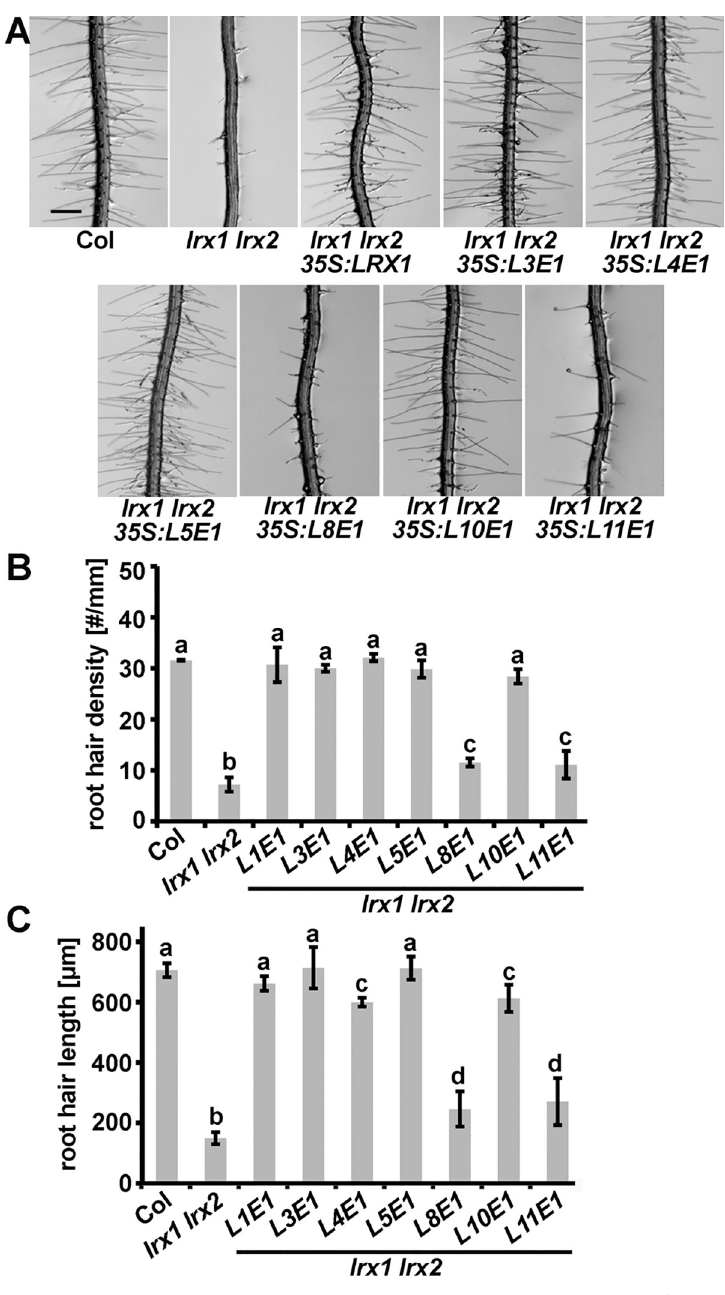
Fig 6. Complementation of the lrx1 lrx2 phenotype by different LRXs . (A) Complementation of the lrx1 lrx2 root hair defect by chimeric construct of L3 , 4 , 5 , 8 , 10 ,and 11 (ATG start codon to CRD) fused to the extensin coding sequence of LRX1 ( E1 ) under the 35S promoter. Representative examples of several independent transgenic lines for each construct are shown. Bar = 0.5 mm. Quantification of the complementation by assessing root hair density (B) and root hair length (C) in the different lines. Seedlings were grown for 5 days on half-strength MS in a vertical orientation. Error bars represent SEM; different letters above the graphs indicate significant differences (T-test, N = 50, P < 0.01). The pollen-expressed LRX8-LRX11 [37] form a separate phylogenetic clade and are more similar to pollen-expressed LRXs of other plant species than to vegetative LRXs of Arabidopsis [47,48]. It was tested whether the N-terminal moieties of these LRXs in combination with the